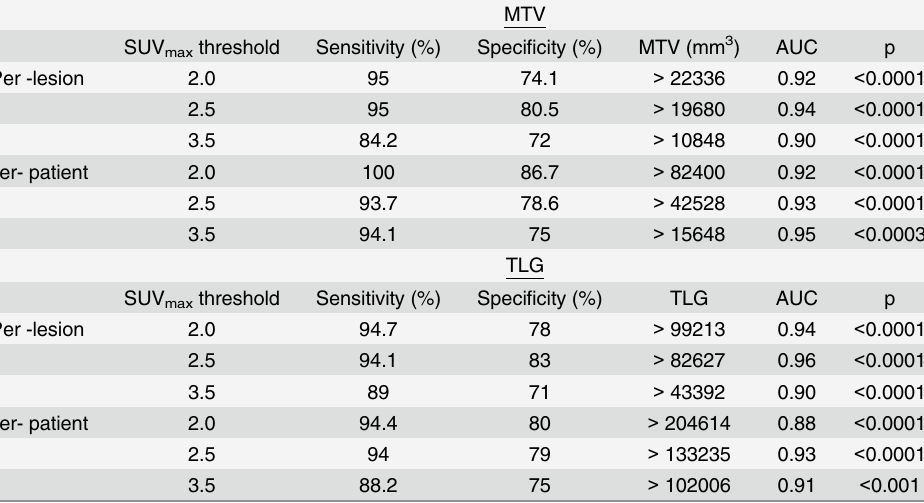
Table 5. ROC analysis for MTV and TLG on both a per-lesion and a per-patient